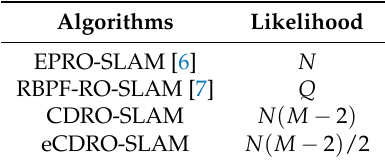
Table 1. Computational complexity of updating the